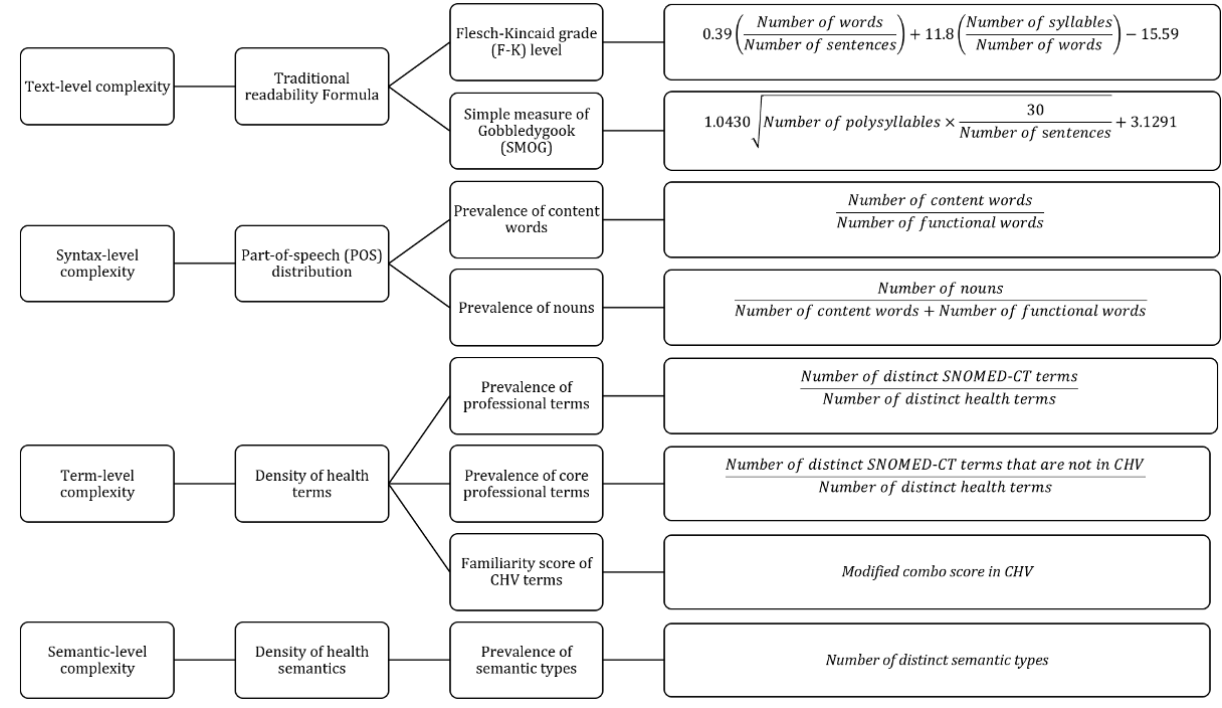
Figure 1. Consumer health language complexity measurement framework